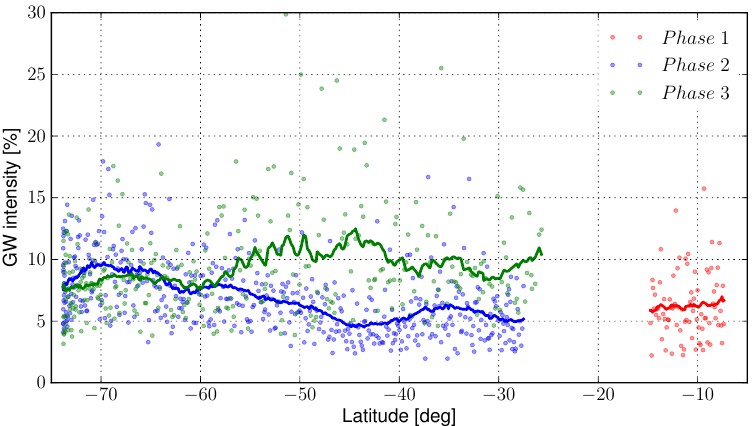
Figure 6. The same as in Figure 5, except for the dependence on latitude. The running means have been calculated by averaging over passes with pericenter latitudes positioned within the around each pass. No more than 40 passes closest in time have been considered in order to avoid averaging over hundreds of passes at high